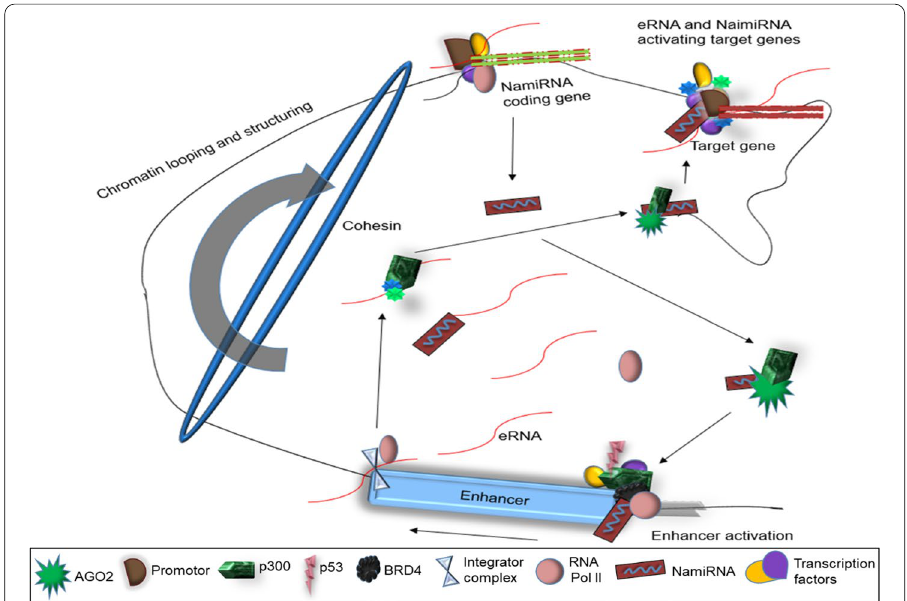
Fig. 5 The proposed model of eRNAs and NamiRNAs cooperatively enhancing and activating target genes. NamiRNAs form a complex with AGO2 and p300; they bind to enhancers and activate markers such as H3K27ac and H3K27me3, which attract RNA polymerase to recognize and translate the enhancer. Transcribed RNAs bind to p300 and other proteins to activate enhancer features at the target gene’s promoters. The attracted NamiRNAs then attach to the gene’s promoter and subsequently activate the target gene’s expression